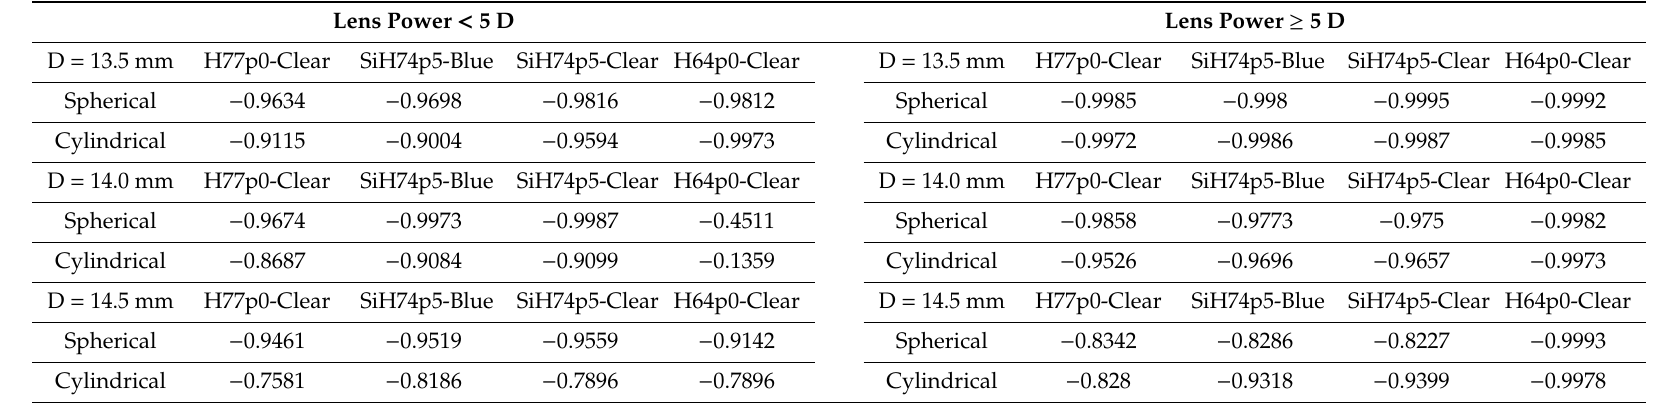
Table 5. Correlation factors between the EPC values produced by each material and the associated lens